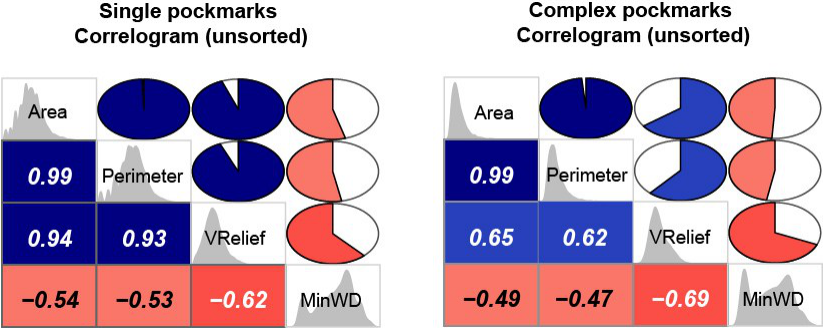
Figure 23. Unsorted correlograms showing the relationships between key pockmark metrics for the three studied regions.